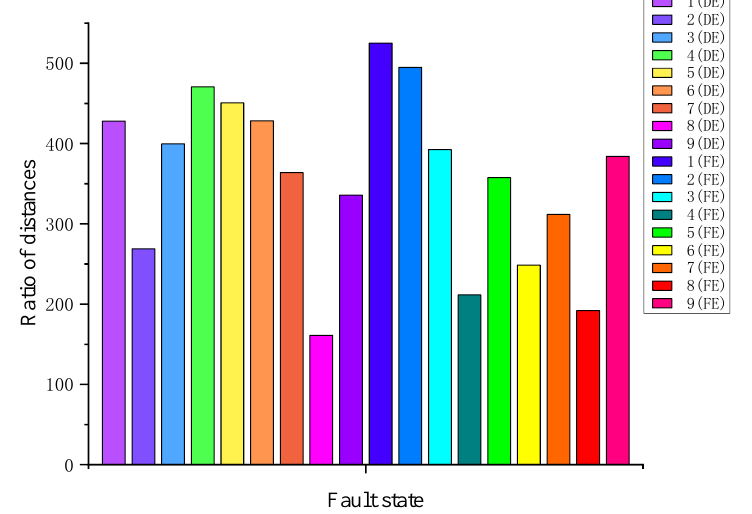
Figure 8. The ratios of S b to S w for each fault state.